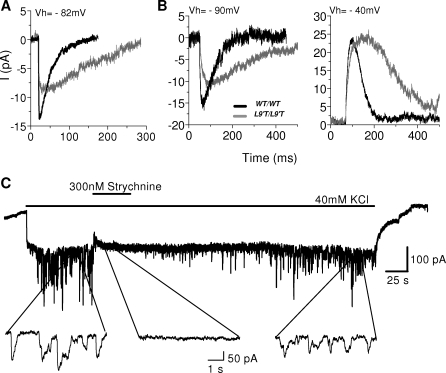
Prolonged Synaptic Currents in IHCs Are Blocked by Strychnine(A) Superimposed representative traces from individual cells of nAChR-only sIPSCs in IHCs from a Chrna9wt/wt; (27 events) and a Chrna9L9′T/L9′T (27 events) mice at a V
hold (Vh) of −82 mV.(B) Superimposed representative traces from individual cells of nAChR+SK synaptic currents in IHCs at a V
hold of −90 mV from a Chrna9wt/wt (84 events) and a Chrna9L9′T/L9′ (16 events), and of −40 mV from a Chrna9wt/wt (54 events) and a Chrna9L9′T/L9′ (14 events). The representative traces shown are the average of the different events in one cell (number of cells per experiment indicated in Table 1). WT, wild type.(C) Representative traces (n = 4 IHCs, 2 animals) of synaptic currents evoked by 40 mM external K+ at V
hold of −90 mV in Chrna9L9′T/L9′. The blow-ups show IPSCs, which disappear in the presence of 300 nM strychnine.